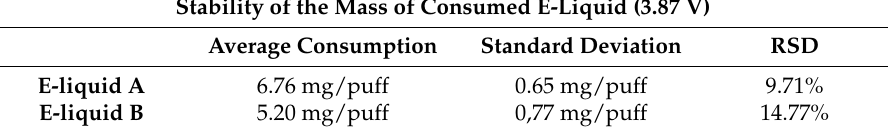
Table 2. Mass variation of aerosolised liquids A and B, from 36 measurements per liquid (6 per U-SAV line) with a setting of 3.87 V.